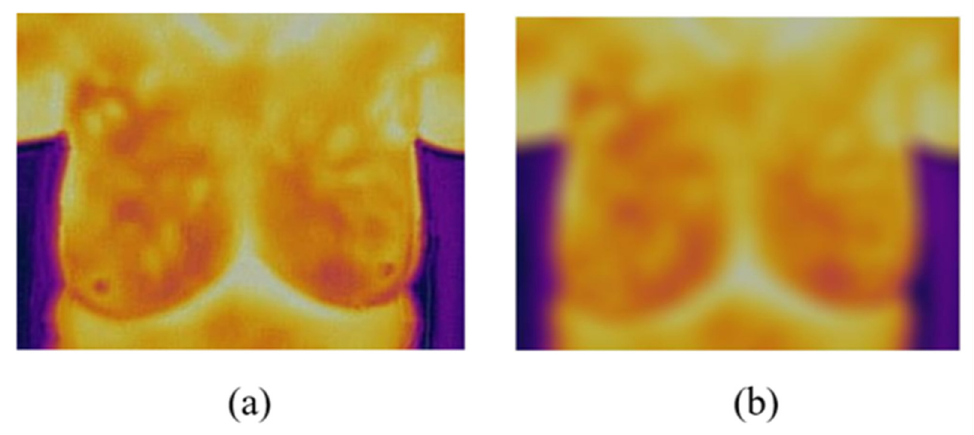
Figure 10. ( a ) Original Thermal Image from Shiraz Medical Center for Breast Cancer & ( b ) Blurry Thermal Image.